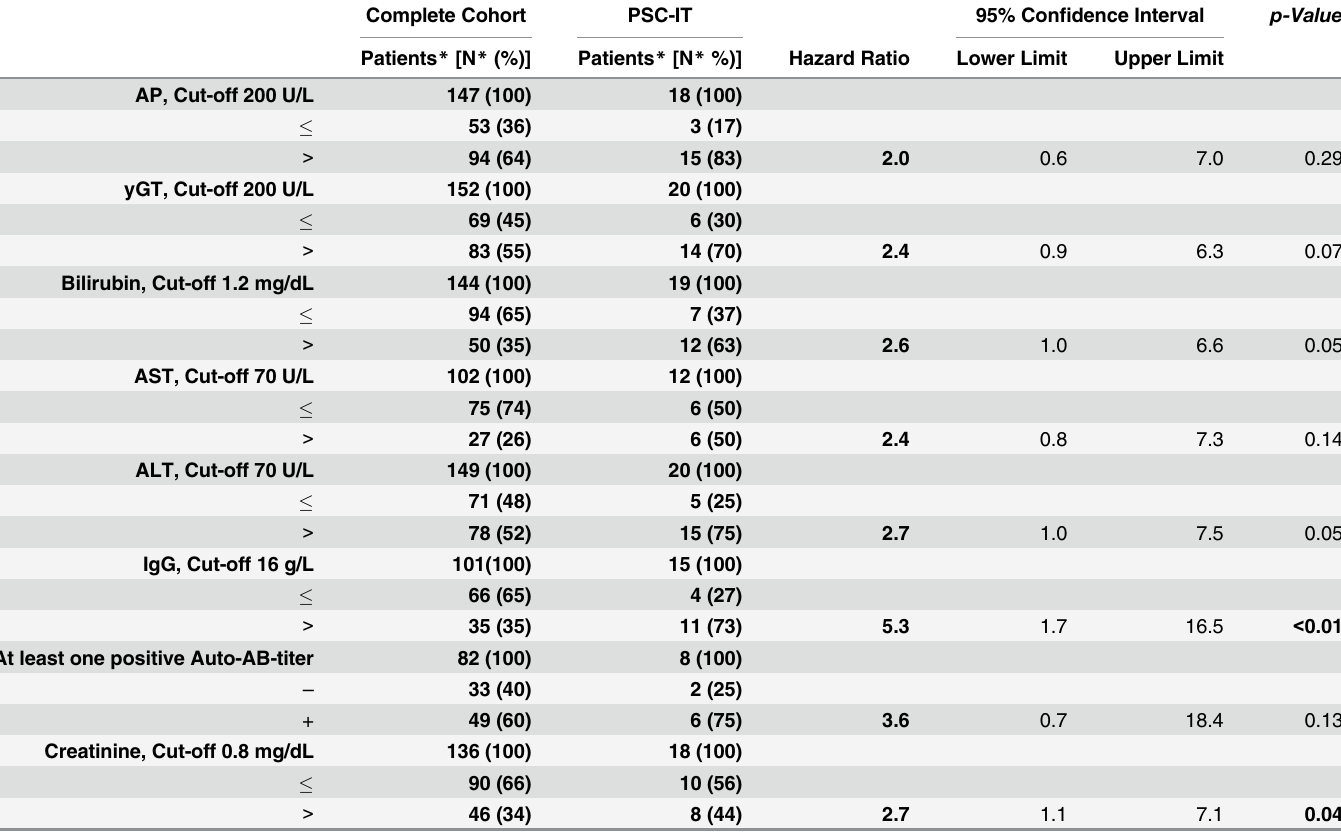
Table 4. Laboratory values at the time of PSC diagnosis and the association with the subsequent introduction of IT during the course of PSC. Complete Cohort PSC-IT 95% Con fi dence Interval p-Value Patients * [N * (%)] Patients * [N * %)] Hazard Ratio Lower Limit Upper